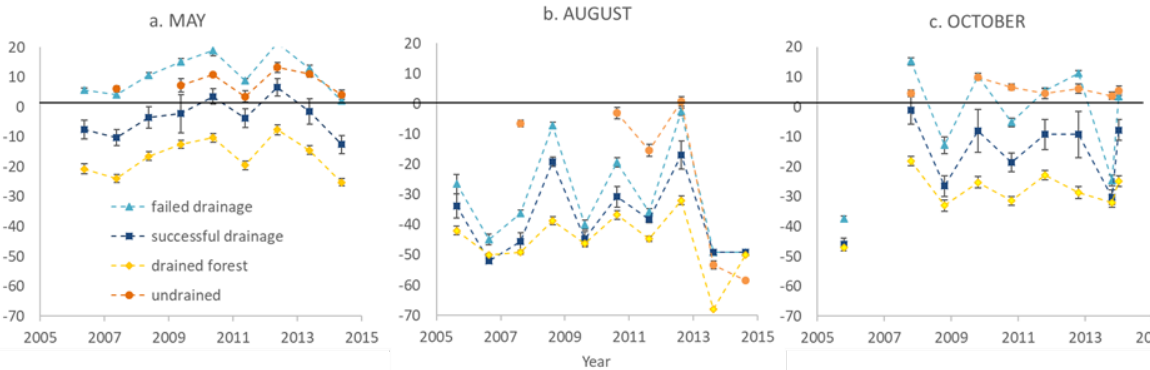
Figure 3. Time series of (a) May, (b) August, and (c) October water table depths with standard error during 2005–2014 for Undrained (orange), Drained forest (yellow), and two subsets of Poorly forested drainage sites: Failed drainage (turquoise) and Successful drainage (dark blue).